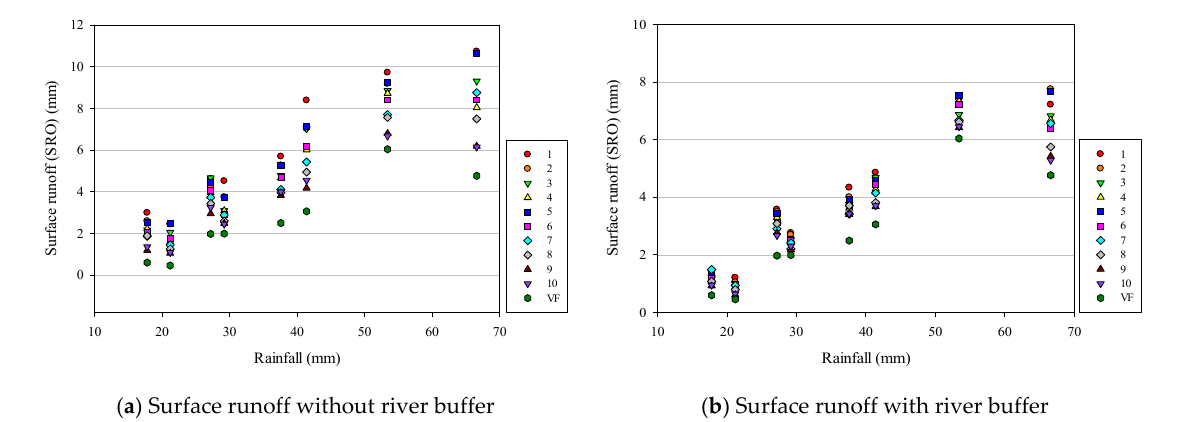
Figure 13. Relationship between rainfall and surface runoff in the different scenarios.